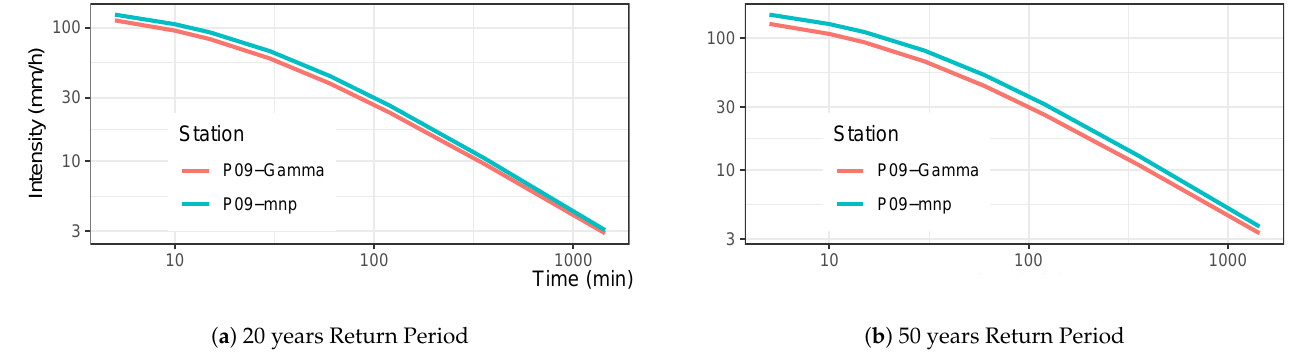
Figure 8. Comparison of IDF curves fitting Gamma and mnp